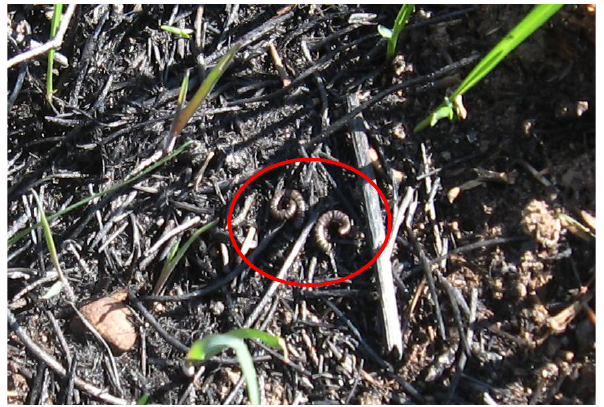
Fig. 5. Evidence of earthworm activity (indicated with a red circle) Fig. 6. Evidence of earthworm activity (indicated with a red circle) in the 2 in the burned plot 17days after the burned plot 17 days after the fire. 3